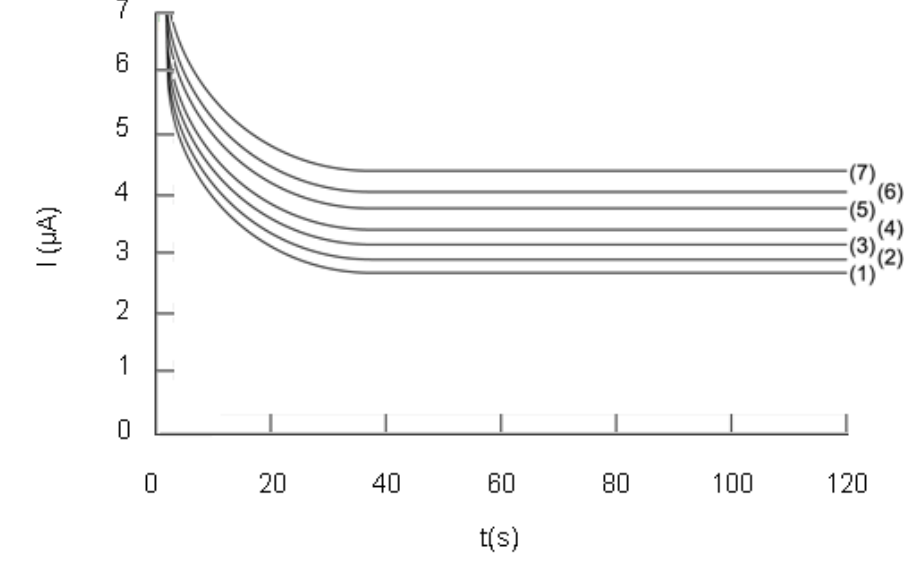
Figure 6 . Chronobiamperograms obtained for different Trolox ® concentrations: (1) 0 µM, (2) 5 µM, (3) 10 µM, (4)-15 µM, (5) 20 µM, (6) 25 µM, (7) 30 µM; conditions:110 µM DPPH/100 µM DPPH·, potential difference, Δ E = 200 mV (for details see Experimental).